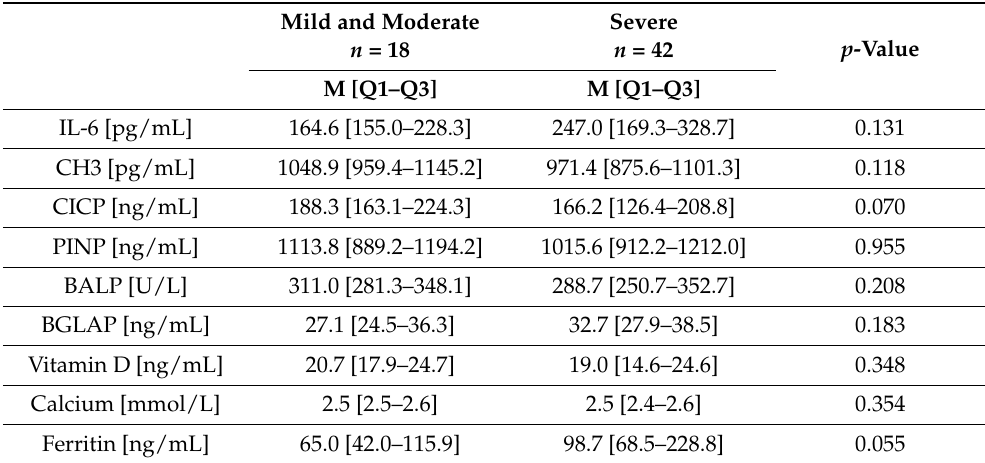
Table 4. Comparison of concentrations of interleukin 6 (IL-6); citrullinated histone CH3 (marker of neutrophil extracellular trap); markers of bone formation (osteocalcin (BGLAP), bone alkaline phosphatase (BALP), N-terminal propeptide of type I procollagen (P1NP)); and the bone resorption marker C-terminal telopeptide of type I collagen (C1CP), according to the severity of haemophilia (mild/moderate, severe) (median and